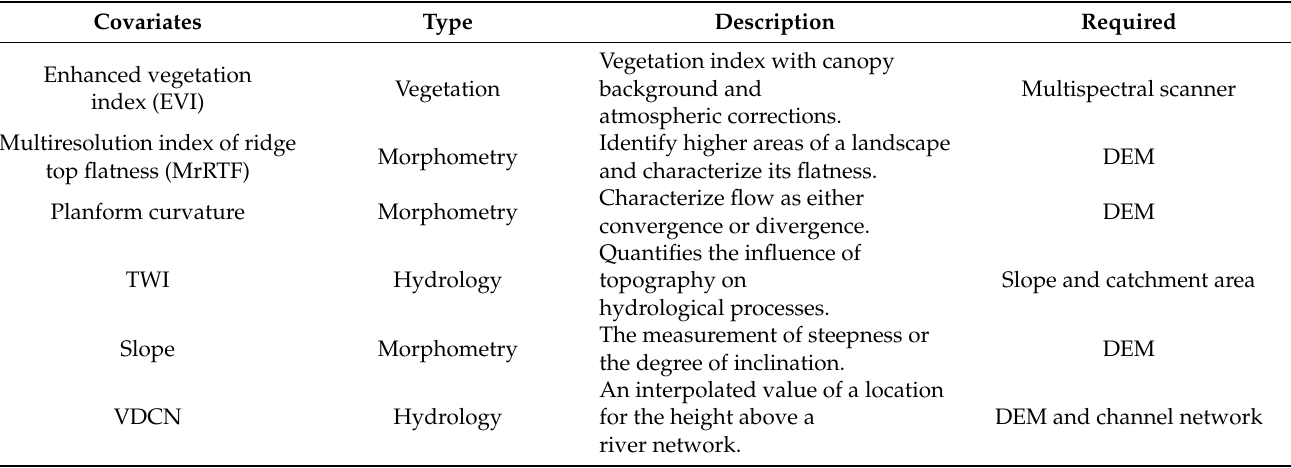
Table 2. Summary of the terrain and vegetation covariates created from the DEM and Sentinel 2 used in the